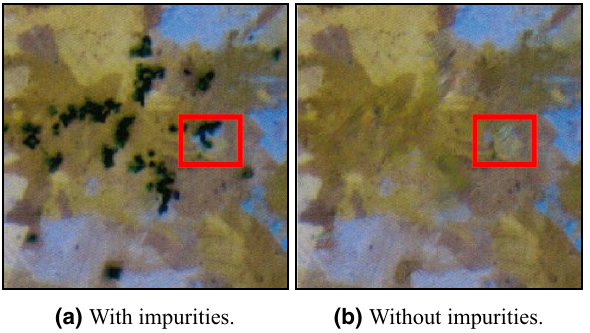
(a) With impurities. (b) Without impurities. Figure 9. Zoomed portion with and without impurities.The blue grain in the red square disappeared in the inpainted